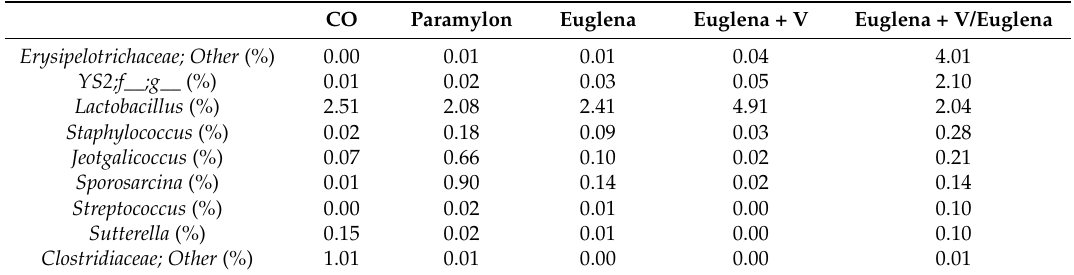
Table 5. Gut microbiota (genus level) that increased by more than 2 times or decreased to 1/2 or less in the Euglena + V group compared to the Euglena